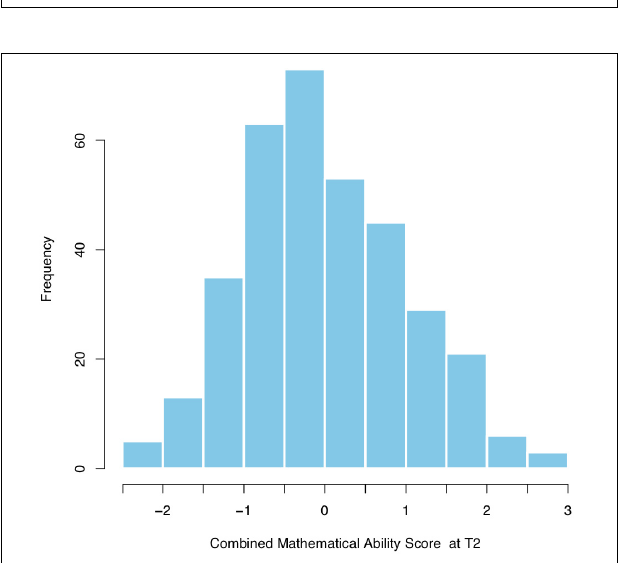
FIGURE 4 | Distribution of Combined mathematical ability score (CMAS) at T2 in the sample of the study ( n = 346).